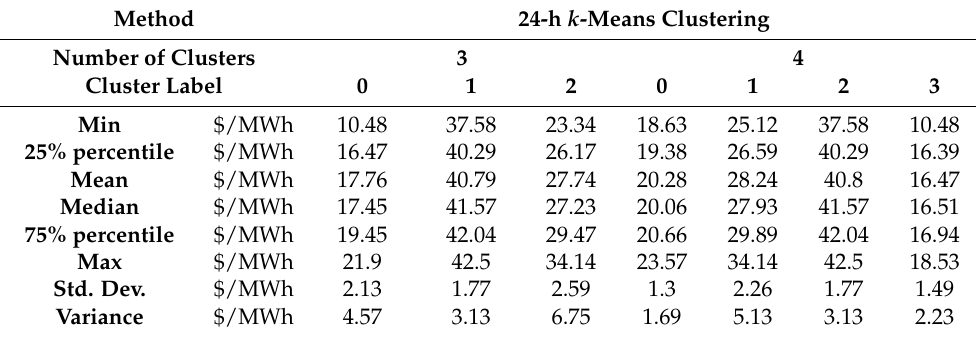
Table 1. Statistical measures of k-means